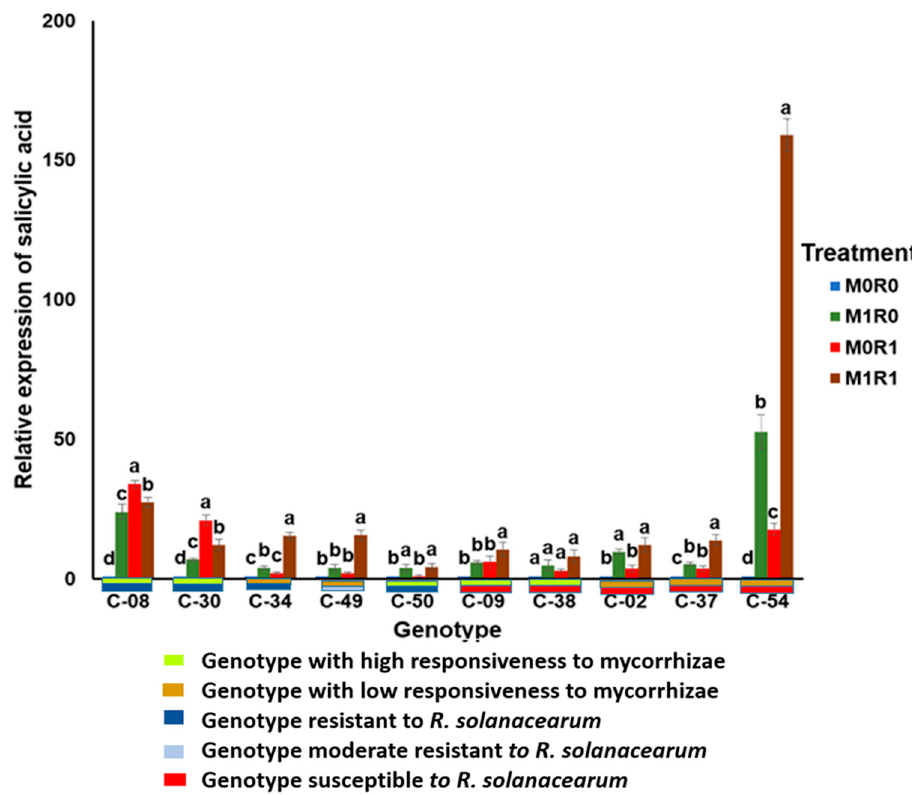
Figure 3. Relative gene expression of salicylic acid (SA) in the tropical chili pepper genotypes. Note: Plants without mycorrhizae (M0); plants inoculated with mycorrhizae (M1); plants not inoculated with R. solanacearum (R0); plants inoculated with R. solanacearum (R1). Bars represent mean ± standard deviation. The same lowercase letters indicate no significant difference in mean values between treatments in each genotype according to the Scott-Knott test at a significance level of 0.95.